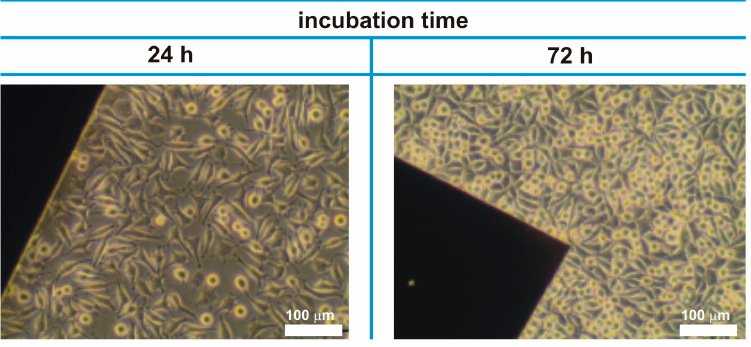
Figure 3. Confluency levels and changes in the morphology of L929 cells in direct contact with Cu 25 Ti 75 thin film, recorded after 24 and 72 h of incubation. Coatings 2021 , 11 , x FOR PEER REVIEW L929 cells in contact with material extracts as well as in direct contact with the sample maintained the correct morphology (no cell lysis and no reduction of cell growth). In di- rect contact with the sample, no zone of strong migration of copper ions at the edge of the sample was observed (Figure 1).